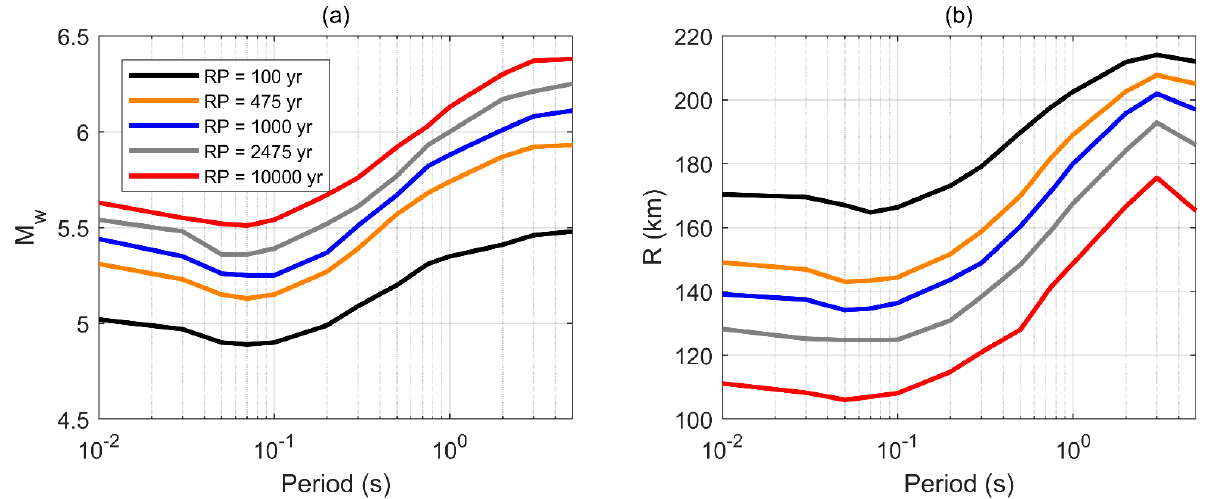
Figure 8. Mean ( a ) magnitude and ( b ) source to site distance contributing to the hazard at different spectral and return periods (RP).